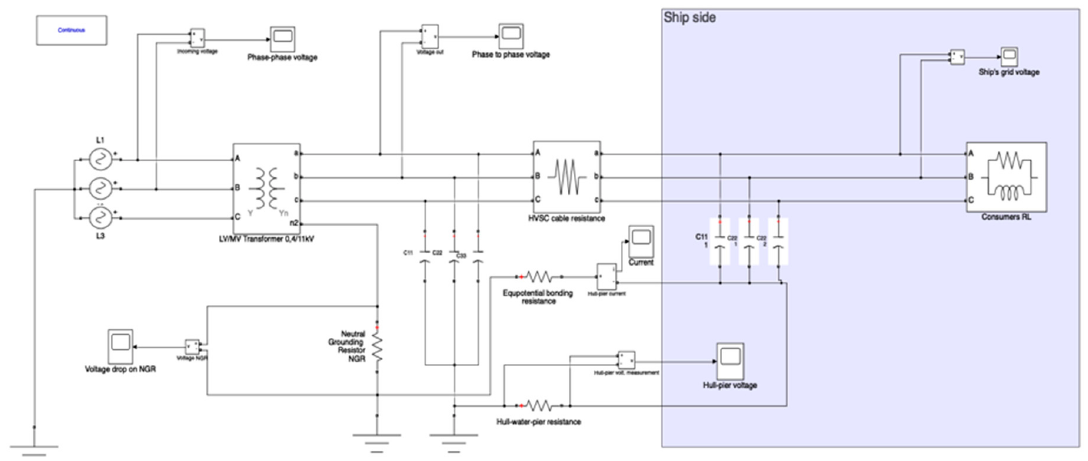
Figure 12. Simulink Model #2 of the ship HV system and stray currents flowing across seawater from the hull to pier.